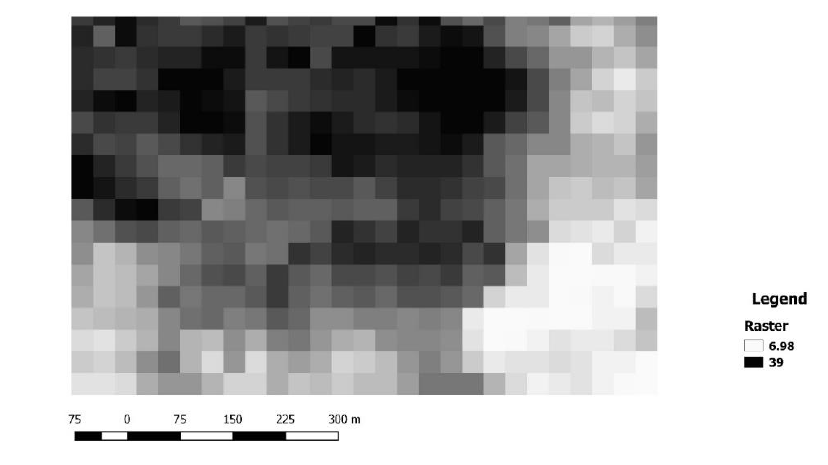
Figure 1. Elevation data extracted from SRTM data